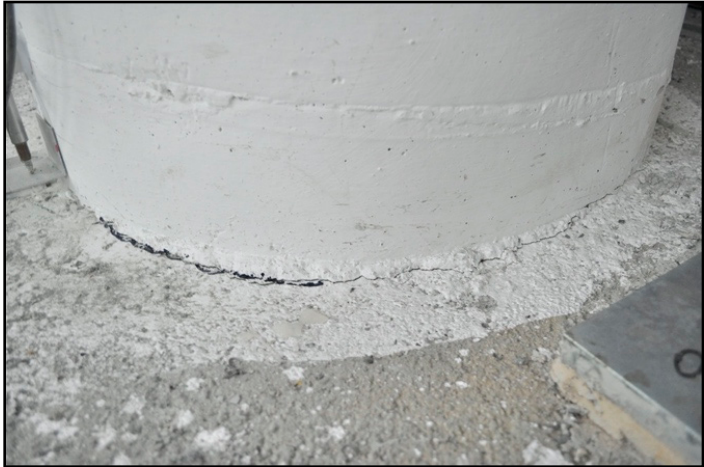
Figure 11. The bridge model: observed crack after shaking.